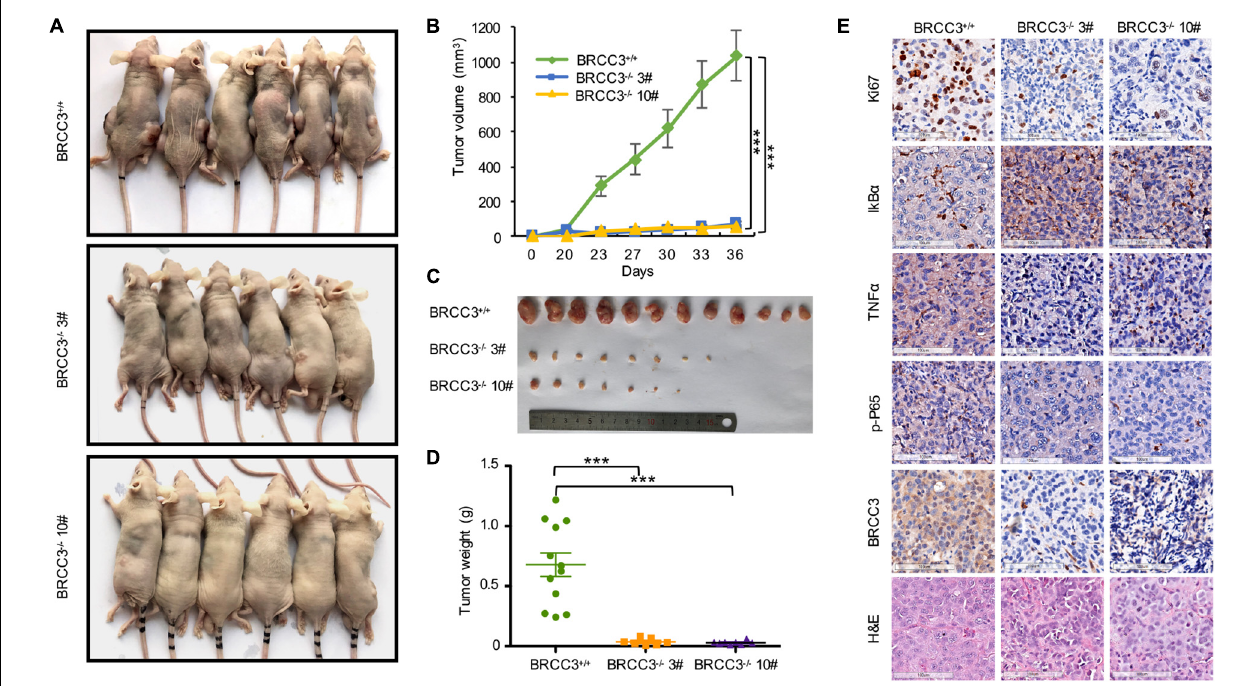
FIGURE 6 | The depletion of BRCC3 inhibits bladder cancer tumorigenesis in vivo . (A) Xenograft models ( n = 6) were established by subcutaneously inoculating wild-type or BRCC3-KO cells and allowing the cells to grow for 5 weeks. Then the mice were sacrificed and the tumors were removed and weighed. (B–D) The tumor volume and weight measurements are shown. (E) Representative H&E staining and immunohistochemical staining of the xenograft tumors from the tumor-bearing mice in the wild-type and BRCC3-KO groups, showed the deficiency of BRCC3 (the fifth panel) and the upregulation of I κ B α expression (the second panel), the downregulation of Ki67 expression (the top panel), TNF α expression (the third panel) and p-P65 expression (the fourth panel) in the BRCC3-KO groups. Statistical analysis of the tumor volume and weight were performed using one-way ANOVA. The means ± standard error of three independent experiments is shown. * P < 0.05, ** P < 0.001, and *** P < 0.001 compared with controls.